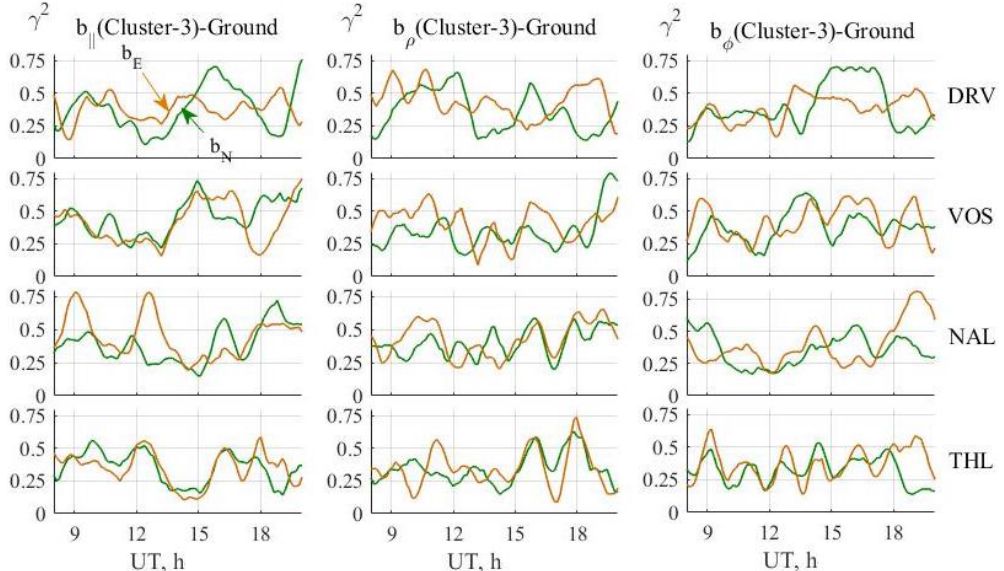
Figure 11. Time variations in average spectral coherence in the 1.2–1.9mHz frequency band for all component pairs formed from Cluster 3 and the four stations. The three columns correspond to the respective b || , b ρ , and b ϕ Cluster components, and the rows show the respective DRV, VOS, NAL, and THL stations. The b N and b E components on Earth are shown in green and orange respectively.